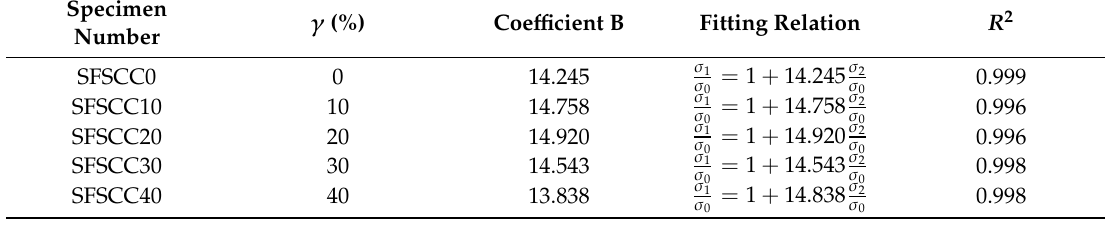
Table 9. Fitting relationship of SCC.